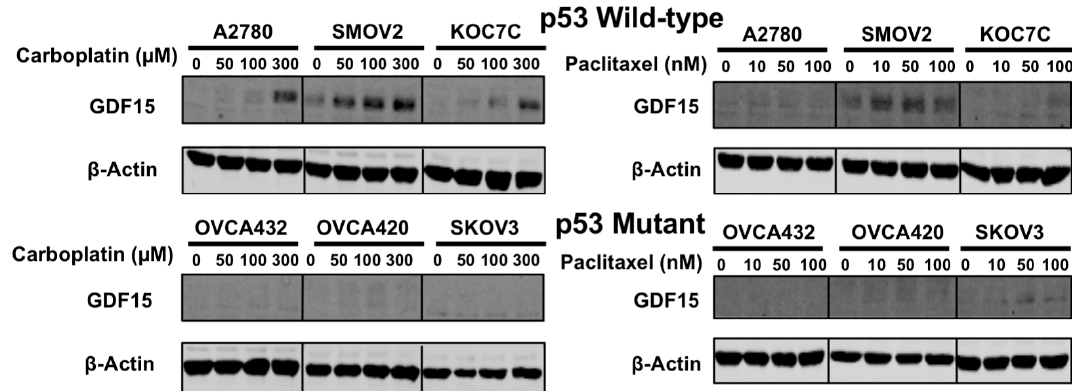
Figure 3. GDF15 expression in ovarian cancer cell lines after treatment with carboplatin or paclitaxel. Cell lines with wild-type p53 (A2780, SMOV2, KOC7C) or mutant p53 (OVCA432, OVCA420, SKOV3) were treated with varying doses of carboplatin or paclitaxel for 24 h.